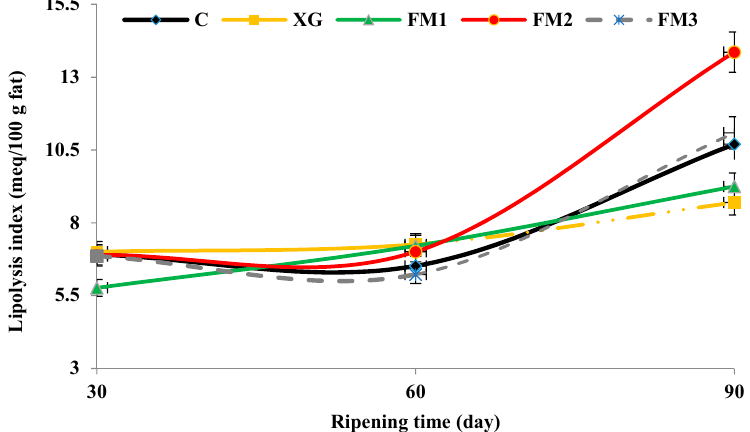
Figure 1. Changes in lipolysis index of coated Cheddar cheeses during ripening. C, control, coated with polyvinyl acetate; XG, coated with 0.5% xanthan gum; FM1, FM2, and FM3 coated with 0.75%, 1%, and 1.25% flaxseed mucilage, respectively. Each dot represents the mean of the experimental data with an error bar of three replications.